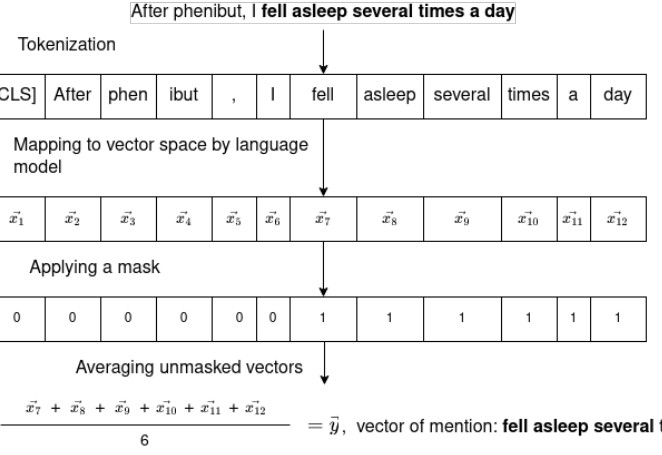
Figure 3. An example of mention vector